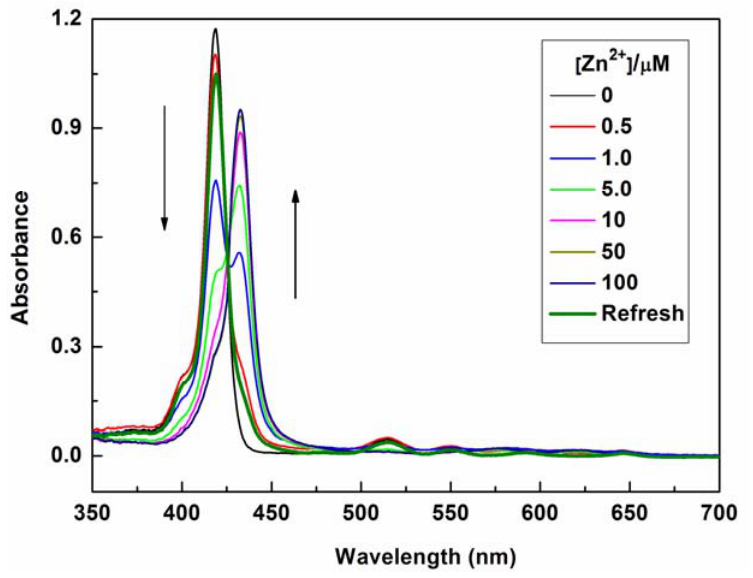
Figure 2. UV–vis spectra of P1 (10 μ M) at pH 7.4 in the presence of different concentrations of Zn 2+ (0, 0.5, 1.0, 5.0, 10, 50, and 100 μ M) in EtOH/H with addition of EDTA.